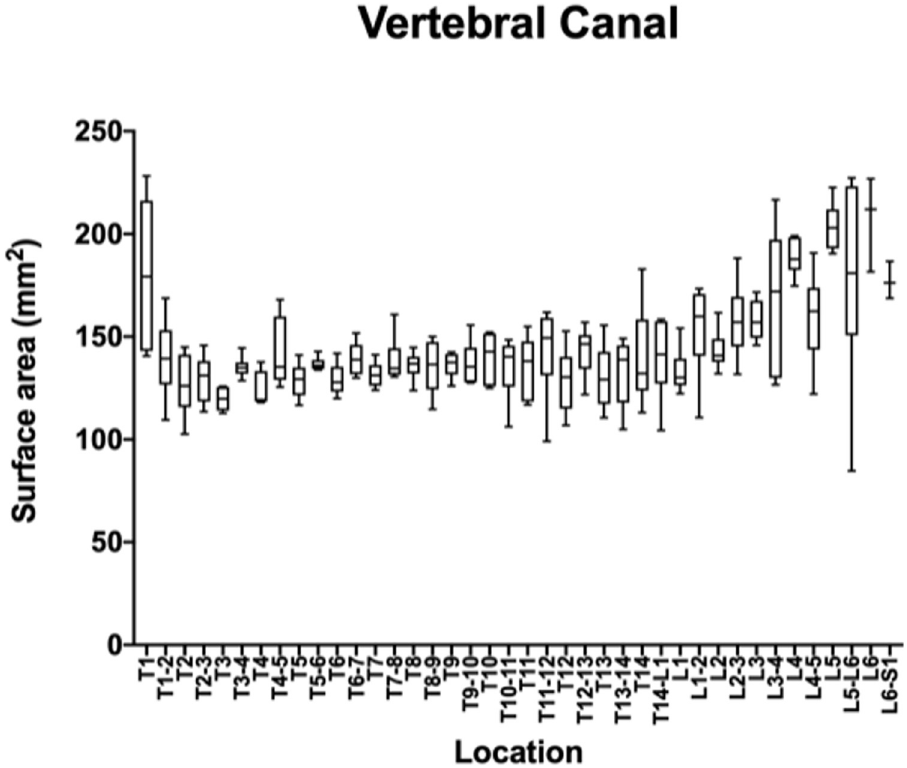
Fig 6. Graph of the vertebral canal surface area (mm2) in 6 Yucatan sows. The median, 75 th , 25 th percentile and the range are shown for each thoracolumbar vertebral